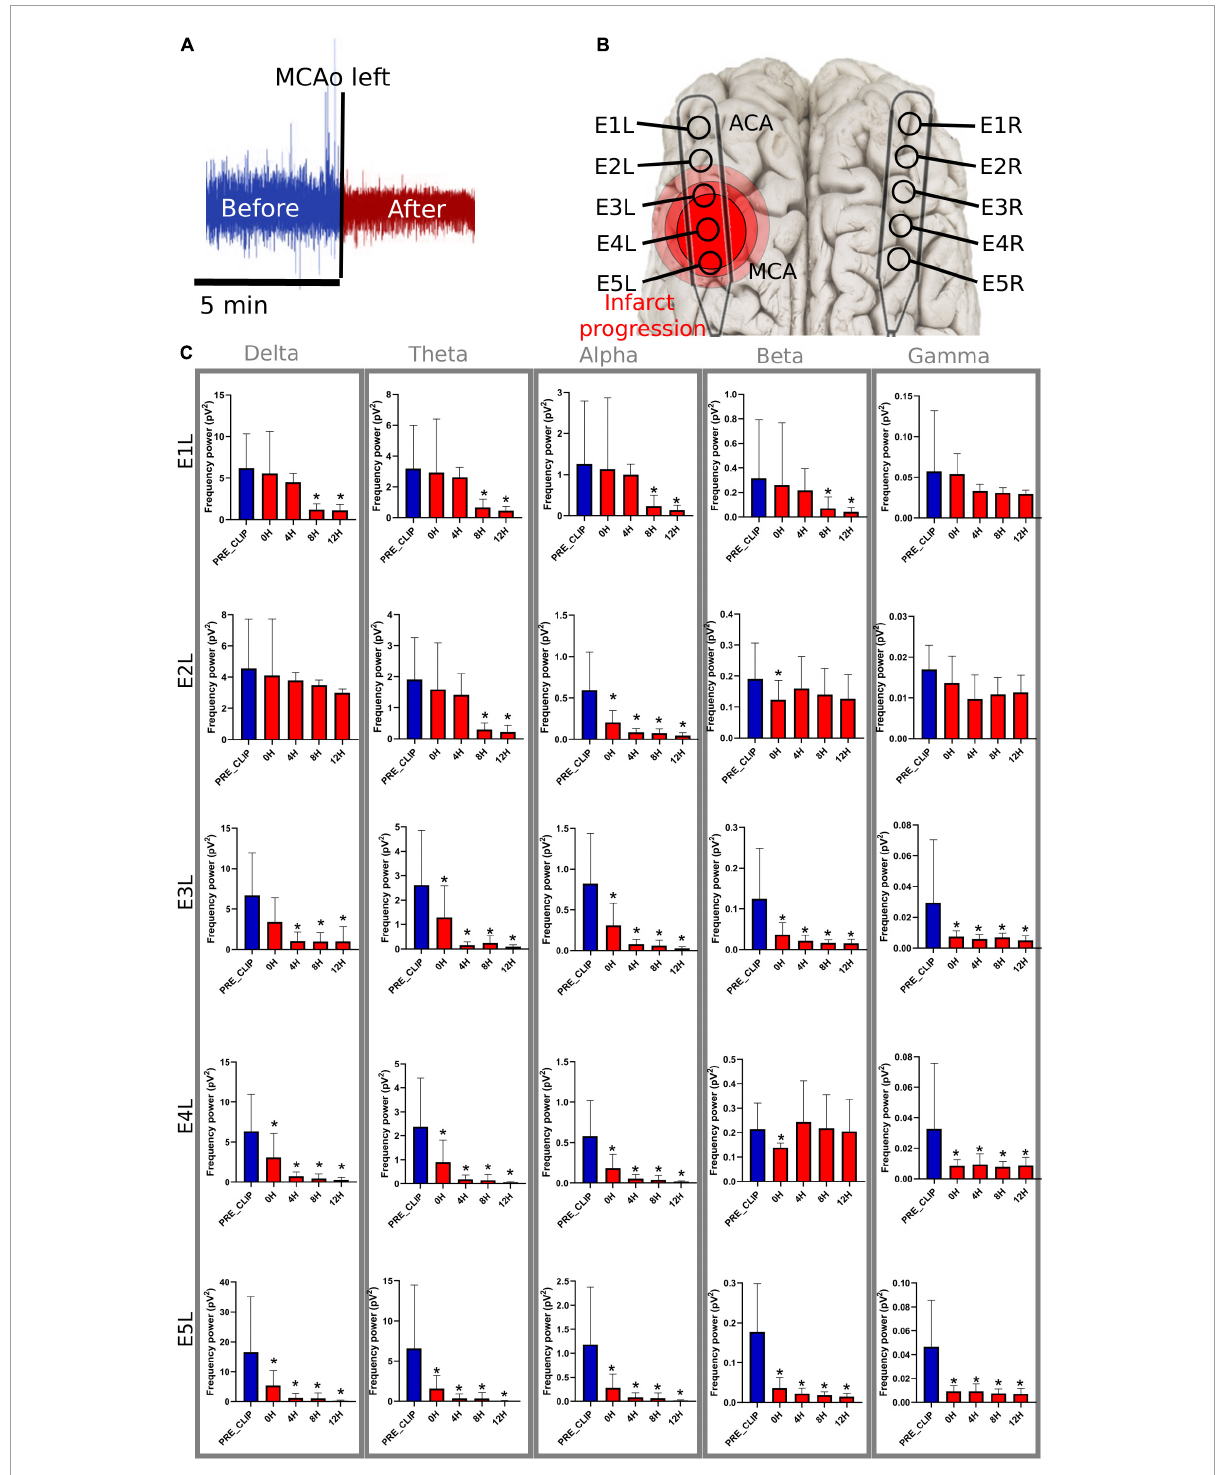
FIGURE3 Frequency bands in the left electrodes after MCAo. (A) The 5-min signal segment before MCAo was used as the baseline to compare the changes in the spectral power at 0 h (5 min immediately after), 4, 8, and 12 h after MCAo. For each timepoint, 5 min of the ECoG recording were used for the analysis. (B) The electrodes were placed parallel over the primary frontoparietal cortex. Electrodes E1L-E5L acquired information from the left ischemic hemisphere. It is speculated that E5 was set over the cerebral cortex near the MCAo, and E1 over the ACA territory. (C) The significant drop in the spectral power of the frequency bands is represented as * ( ≤ 0.05). MCAo, middle cerebral artery occlusion; ECoG, electrocorticography; ACA, anterior cerebral artery; pV2, squared